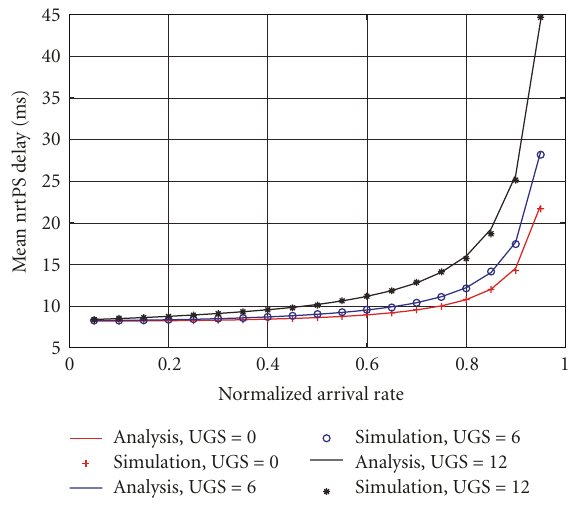
Figure 11: Influence of the UGS tra ffi c on the mean nrtPS packet delay in symmetric system ( N =